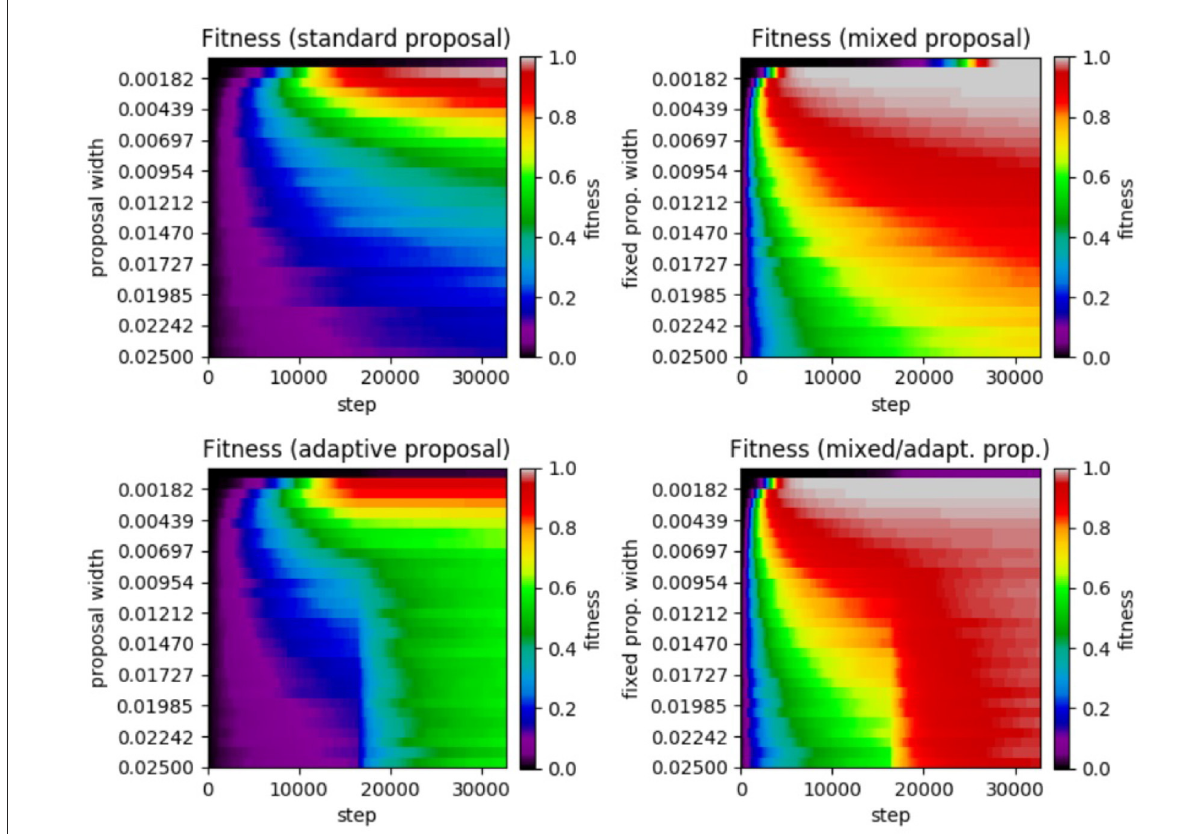
FIGURE6 Results of SA test on the α − pinene application. (Top left) Standard SA. (Top right) Mixed SA. (Bottom left) Adaptive SA. (Bottom right) Mixed/adaptive SA. The horizontal axis displays the step number while the vertical axis represents the the proposal width (increases downward). The color axis displays the average fitness across the 100 runs of each